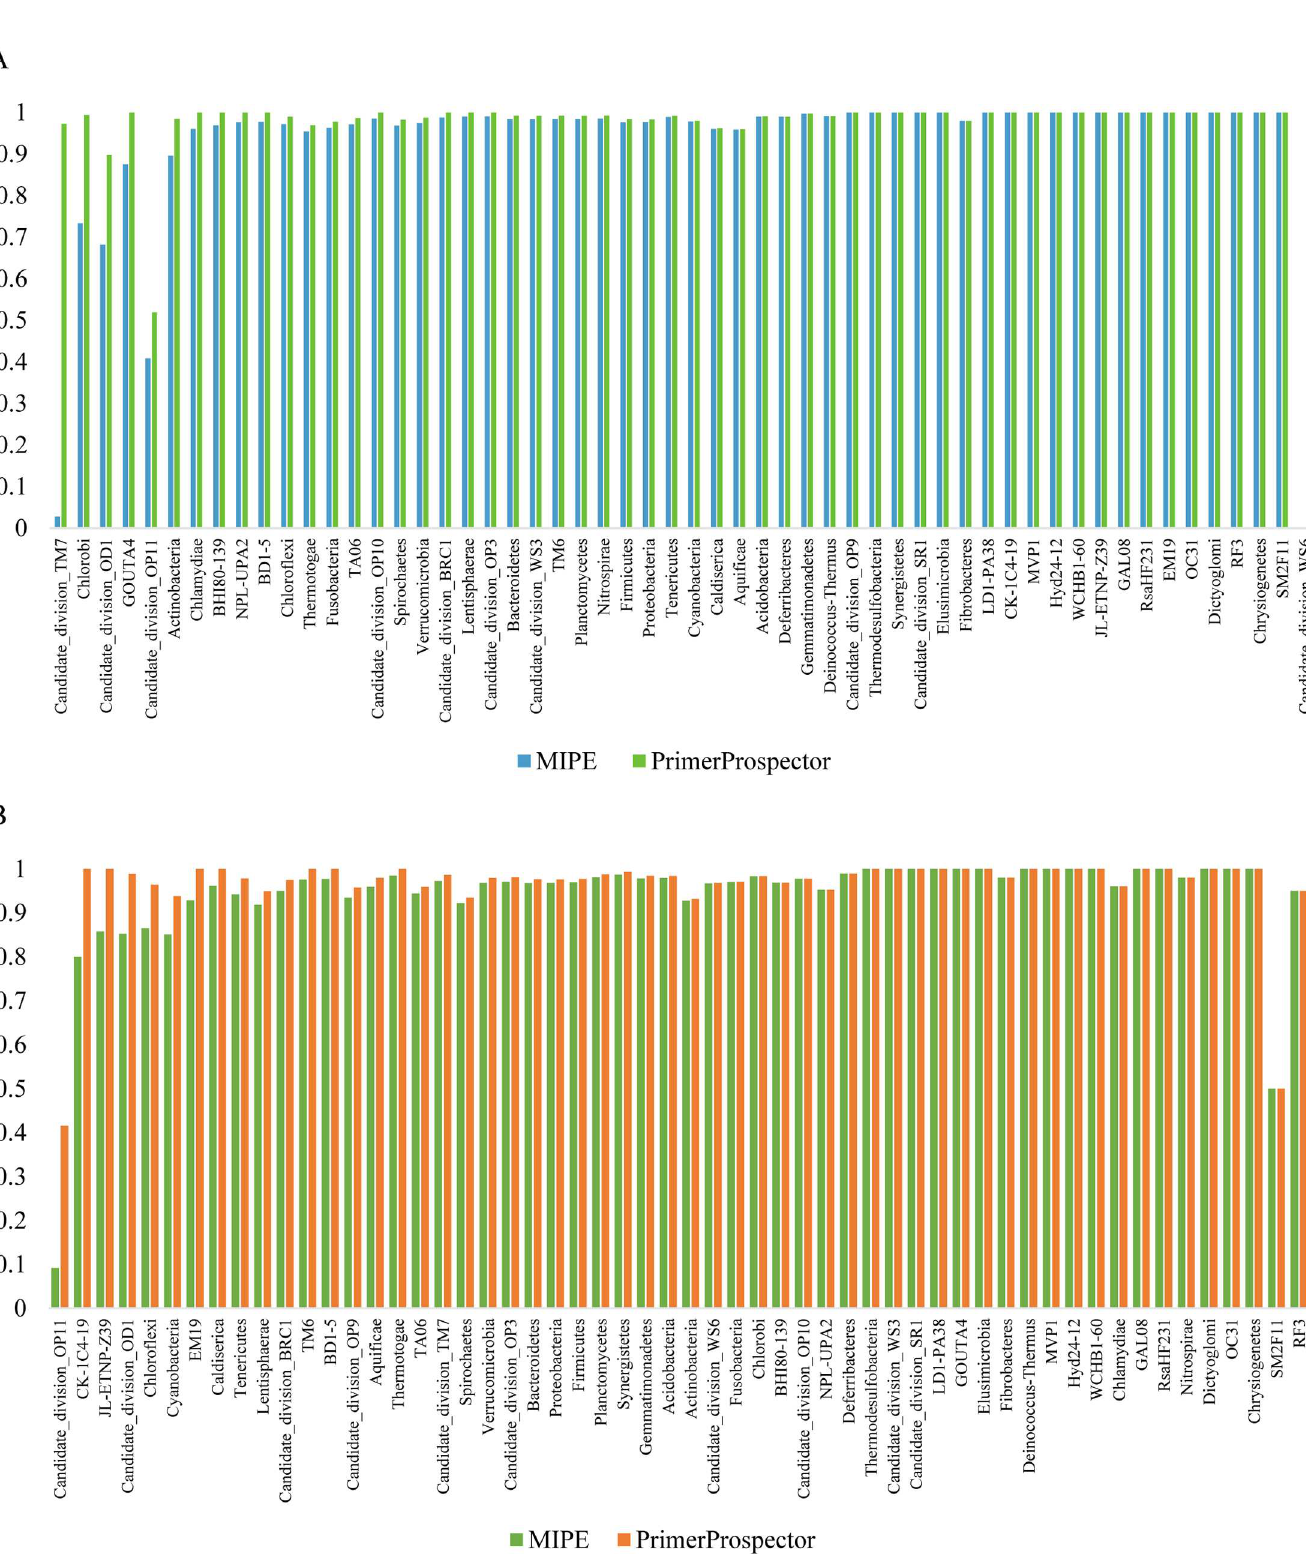
Fig 4. Coverage of the “SILVA test set” with the primers F515 (A) and R806 (B) obtained using MIPE and PrimerProspector. The SILVA test set sequenceswere derived from the SILVA SSU database(v104) and filtered at 97% sequenceidentity with Uclust. The y-axes represent the percent of